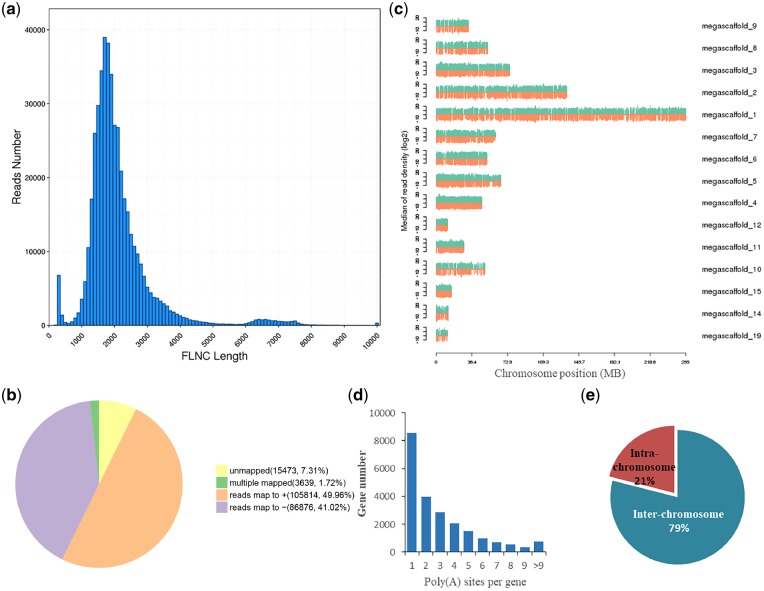
Characterization of lotus transcriptome using Iso-Seq. (a) Density distribution of FLNC reads length obtained by SMART sequencing. (b) The statistics of GMAP mapping by full-length consensus reads. (c) Density distribution of full-length reads in reference genome of lotus. The green is the ‘+’ strand and the orange is the ‘−’ strand. Only the top 10 and other megascaffolds with suitable size and condense mapped reads were shown here. (d) Distribution of the number of poly(A) sites per gene. (e) Ratio of intra- and inter-chromosome fusion transcripts.